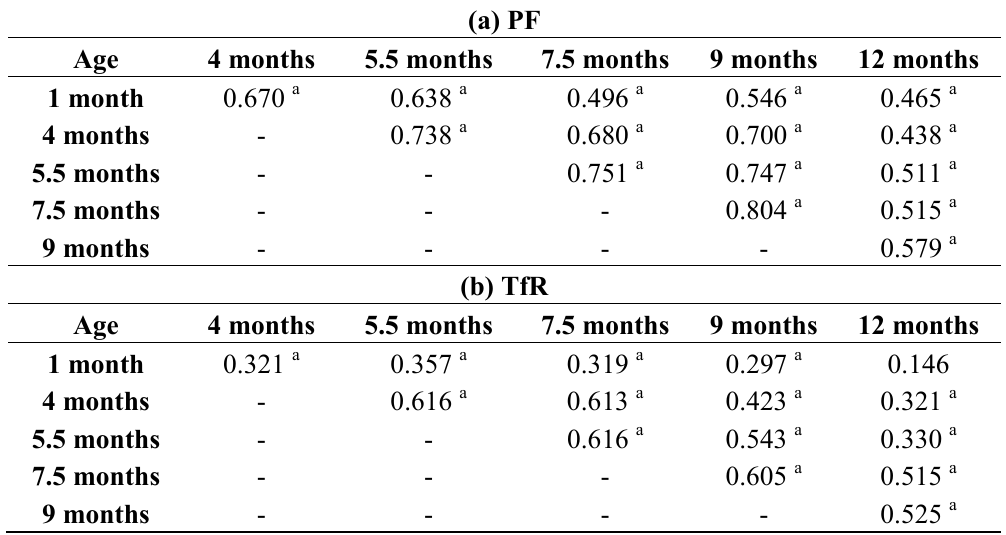
Table 3. Pearson correlations among PF ( a ) values and TfR ( b ) values at different